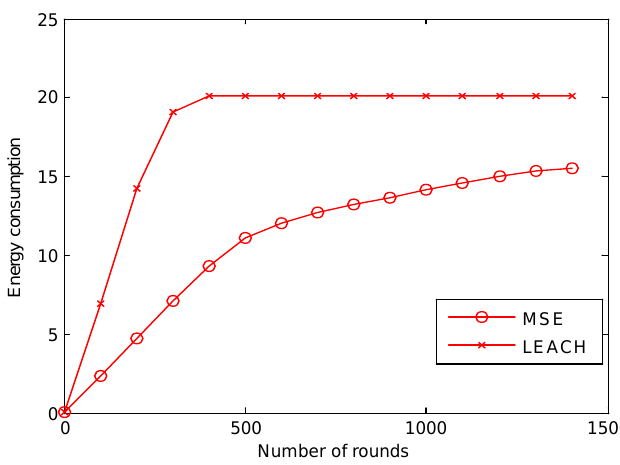
Figure 9. Energy consumption